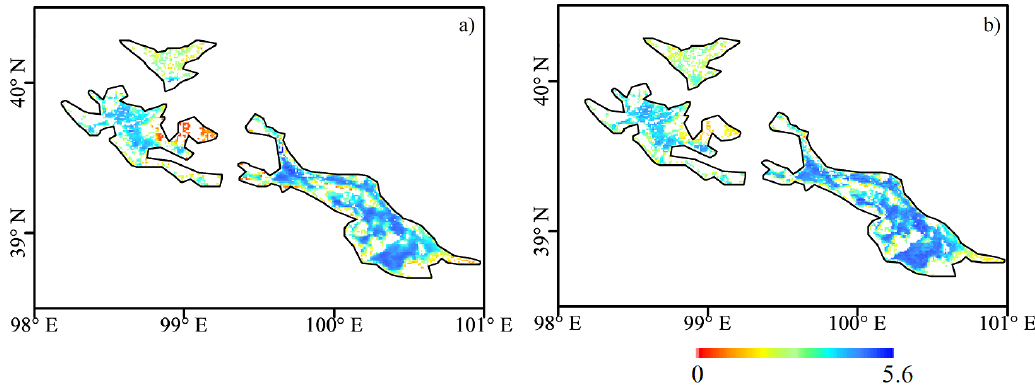
Figure 6. Spatial pattern of ET estimates from the TSVI_DNN and TSVI_Ori models on DOY 204 in 2009. ( a ) ET estimates from the TSVI_Ori model; ( b ) ET estimates from the TSVI_DNN model. Units: mm d −1 .